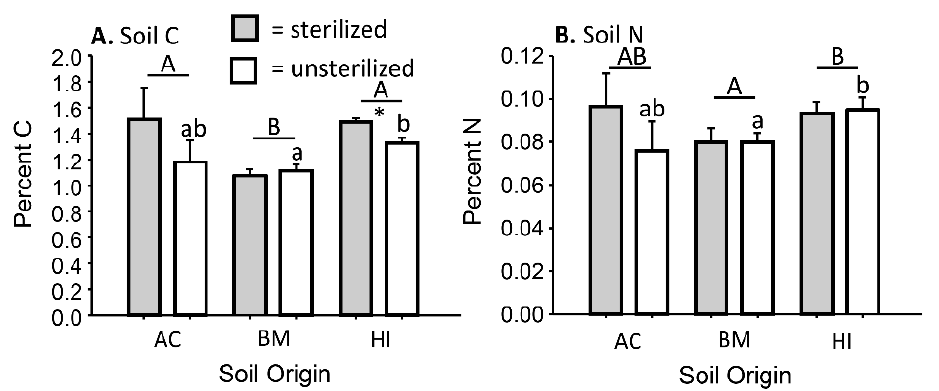
Figure 1. Nutrient concentrations ( A . soil C; B. soil N) among soil origins (AC, Artemisia californica ; BM, Bromus madritensis ; HI, Hirschfeldia incana ) and between soil conditions within soil origins. Capital letters indicate differences in nutrient concentrations among soil origins. Lower case letters represent differences in nutrient concentrations in unsterilized soil among soil origins, and * indicate when nutrient concentrations differed between soil conditions in each soil origin.